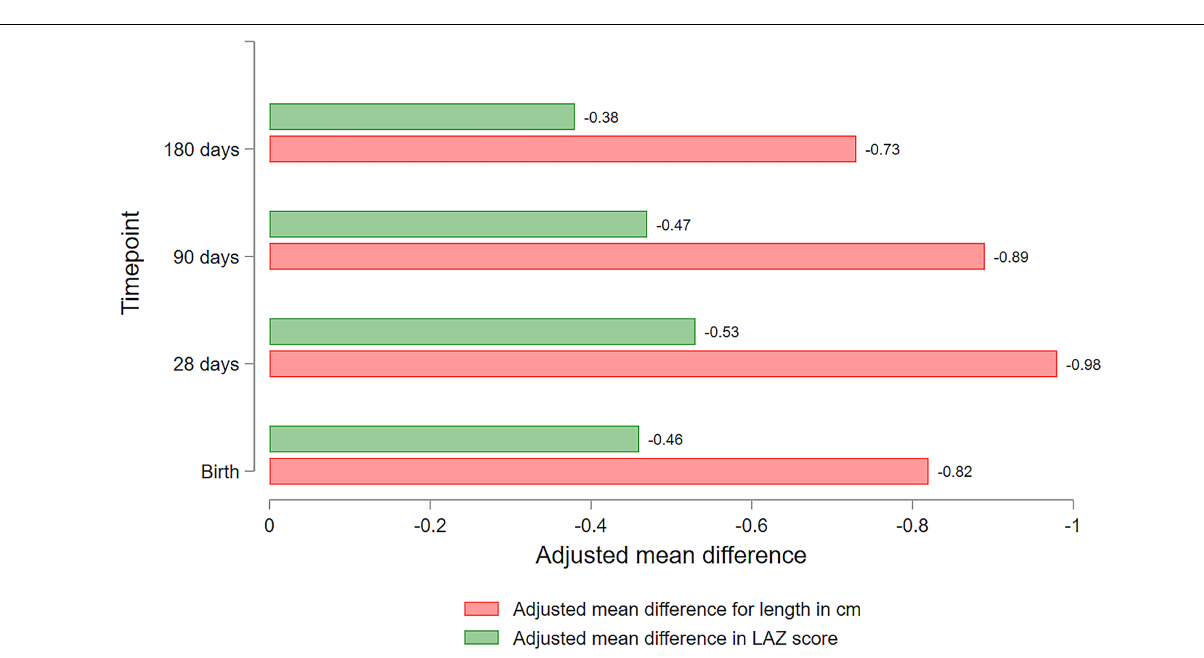
( RR 0.89, 95% CI : 0.83–0.96). Preterm infants ( < 37